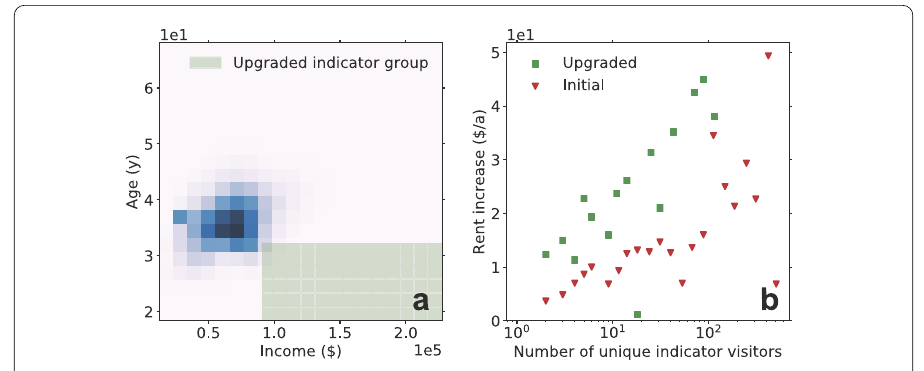
Figure 6 Upgrading the indicator group. ( a ) Income-age-profile distribution for users in Chicago. We assign an income-age profile to each user based on the census median income and median age of the visited neighborhoods (darker colors indicate a higher frequency). The 10 percent ‘youngest’ of the ‘richest’ users represent the upgraded indicator group (green) while all ‘richest’ users represent the initial indicator group. ( b ) For each neighborhood bin in Chicago, we compare the number of upgraded indicator visitors (green) and the number of initial indicator visitors (red) in 2012/2013 with the 2012–2015 change of the census median rent. Using visitors with a high-income-low-age profile as indicator group yields a stronger correlation than using all high-income-profile visitors (upgraded: r s = 0.78; p < 10 –3 ; N = 15, initial: r s = 0.70; p < 10 –3 ; N =